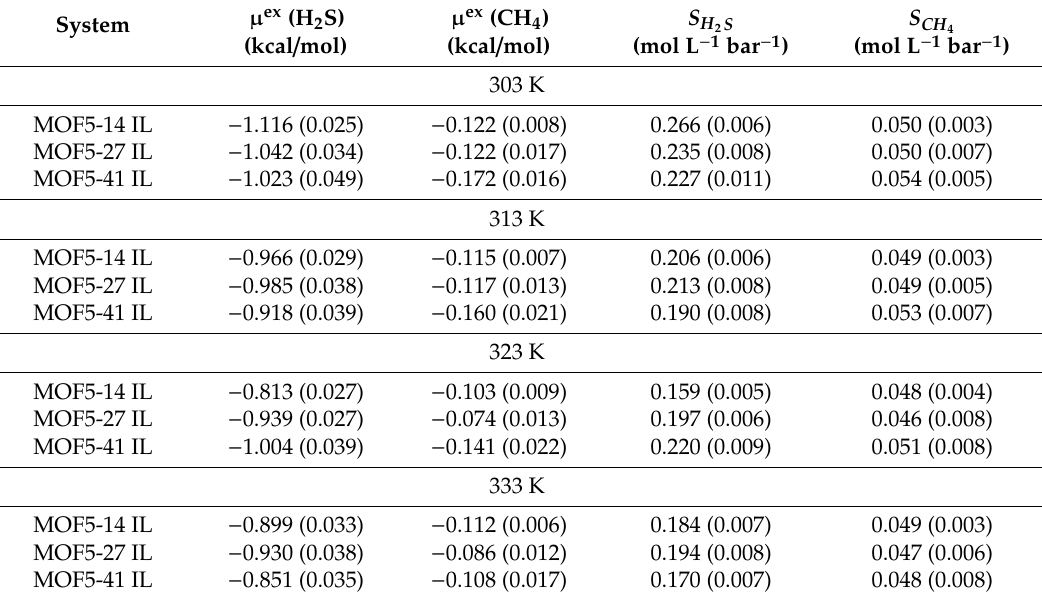
Table4. Excesschemicalpotential( µ ex )andsolubility(S)ofH 2 SandCH 4 insidethe[Chl][SCN] / IRMOF-1 composite, comprising of di ff erent IL loadings at 303, 313, 323, and 333